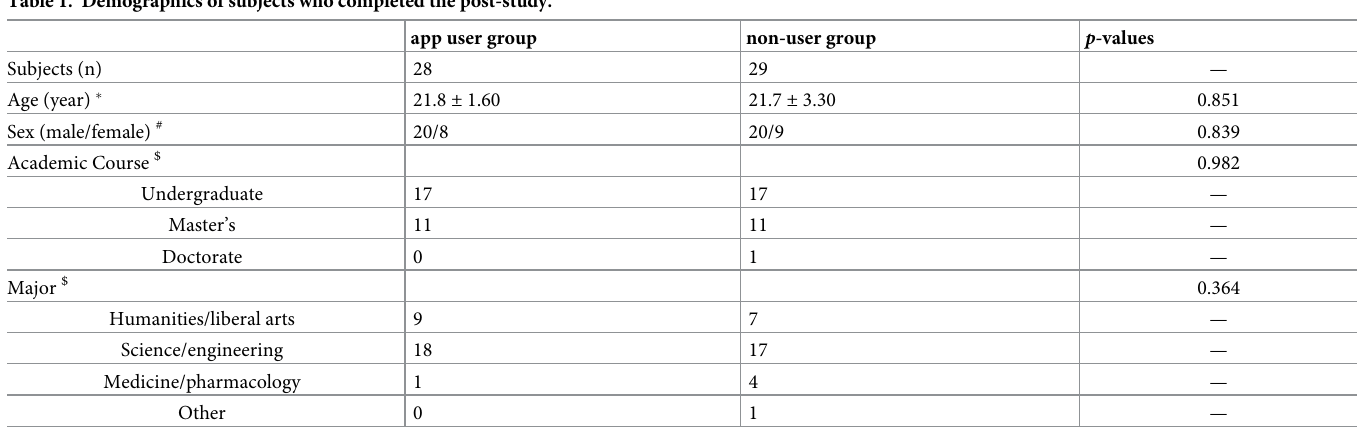
Table 1. Demographics of subjects who completed the post-study.